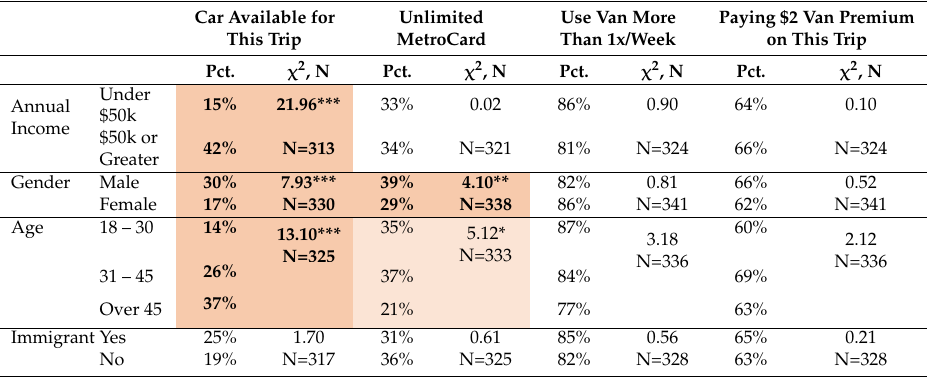
Table 3. Associations between demographics and respondent transport